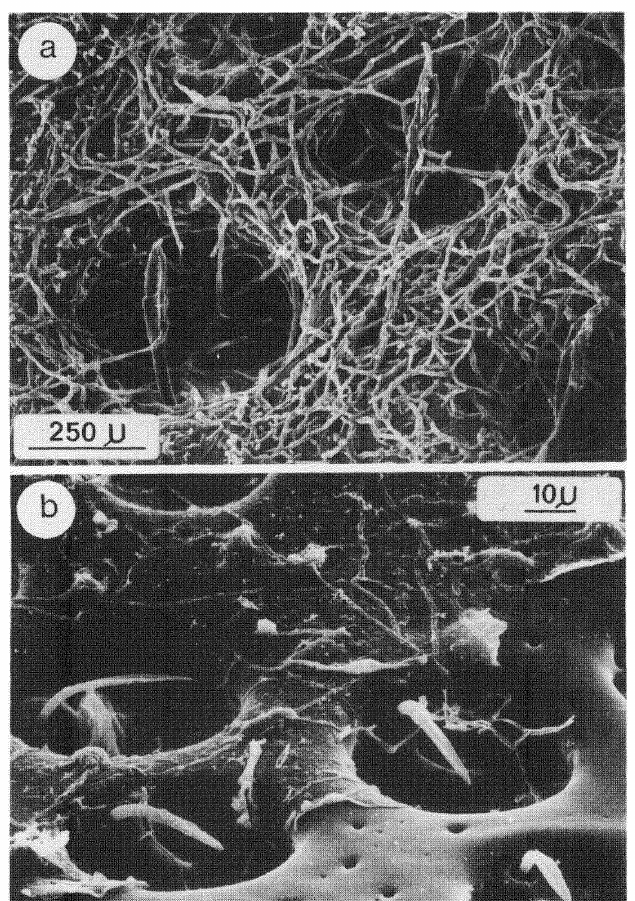
Fig. 3. a.Z. varians (Lignumvitae Key, FL) (same individual as Fig. 2). Close-up of mat covering the large, blade-like setae, b. Z. varians (Card’s Point, FL). Soldier. Clean and coated areas of cephalic shield. Note the pores in the clean section and the uniform coating in addition to some fibers in the encrusted